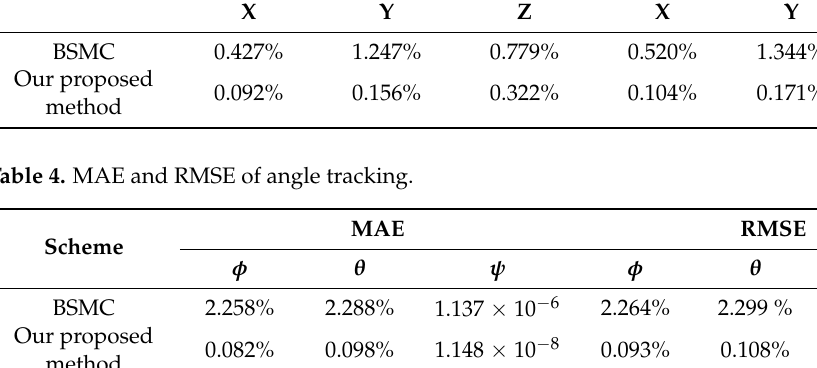
Table 3. MAE and RMSE of position tracking. Scheme